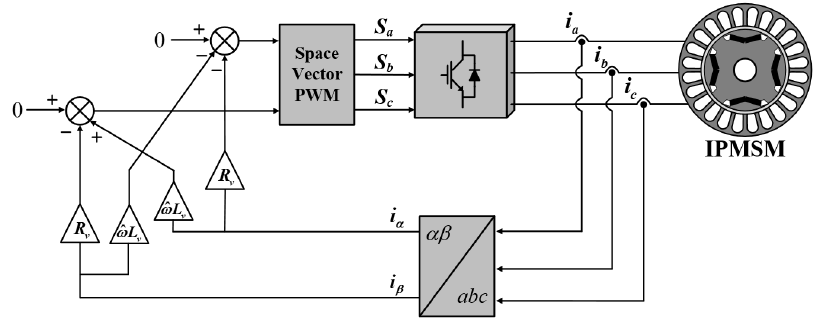
Figure 8. Implementation of proposed virtual impedance-based flying start method.